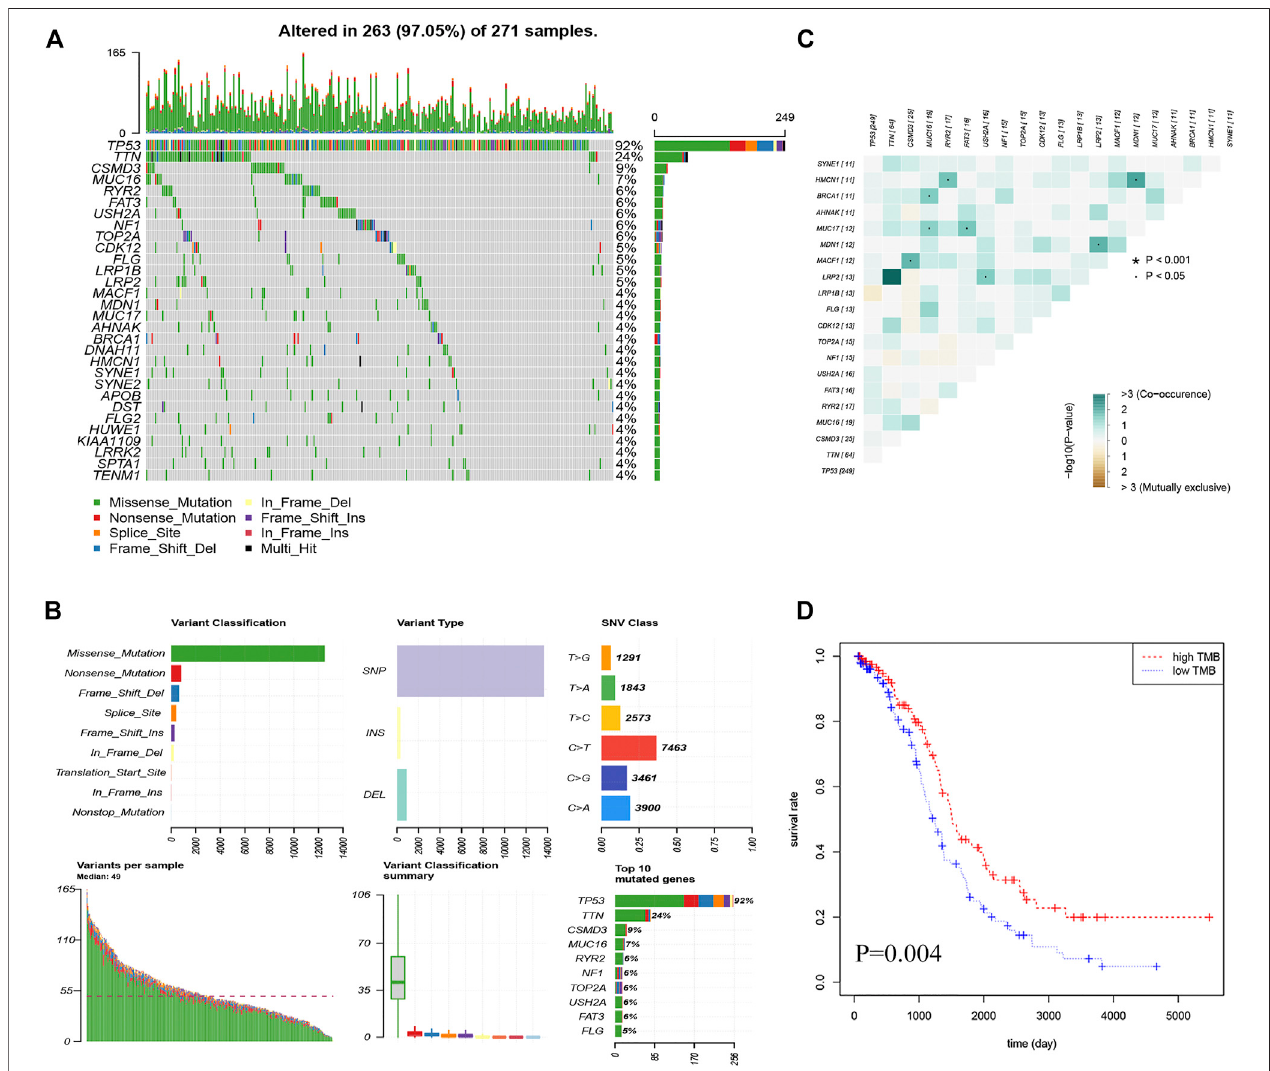
FIGURE 1 | Landscape of the OC mutation pro fi les. (A) Waterfall plots present the landscape of the top 30 genes somatically mutated in 271 OC patients. (B) Variousbargraphsshowsomaticmutationsdata.Variantclassi fi cationrevealthatmissensemutationsarethemost;VarianttypeshowthehighestnumberofSNP(single nucleotide polymorphism); SNV(single nucleotide variants) class show the highest number of C > T; Variant per sample, with a median of 49; Summary of variant type; Top10mutatedgenes (C) CorrelationHeatmapofthetop20mutatedgenes (D) Kaplan-MeiercurvesshowthatOSinthehigh-TMBwassigni fi cantlyhigherthanin the low TMB